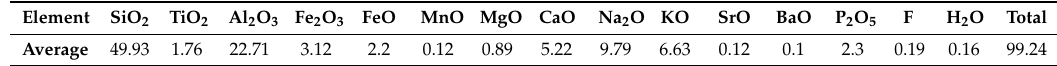
Figure 3. Thin sections of Khibiny apatite ore and massive urtite. Ne—nepheline Ap—apatite, Cpx—pyroxene, Sod—sodalite. Table 1. Average composition of the apatite- bearing intrusion, wt %: [22].